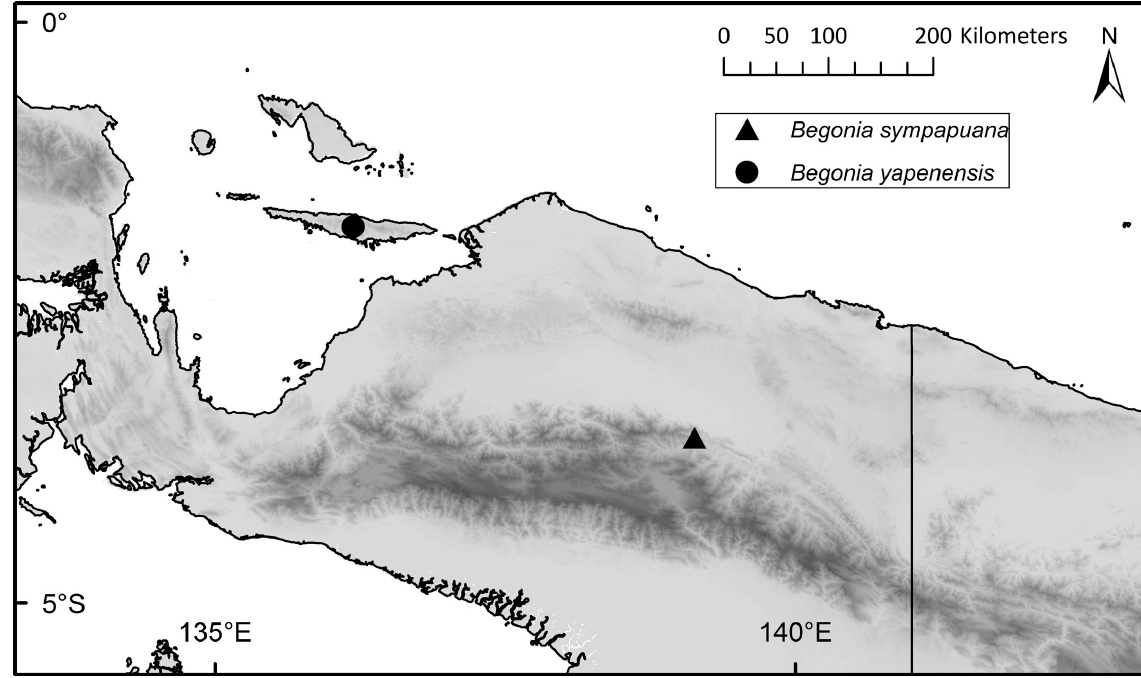
Fig. 2. Map of Tanah Papua, Indonesia, showing the distribution of Begonia yapenensis sp. nov. on Yapen Island, and of the allied Begonia sympapuana in the mountains at the head of the Idenburg